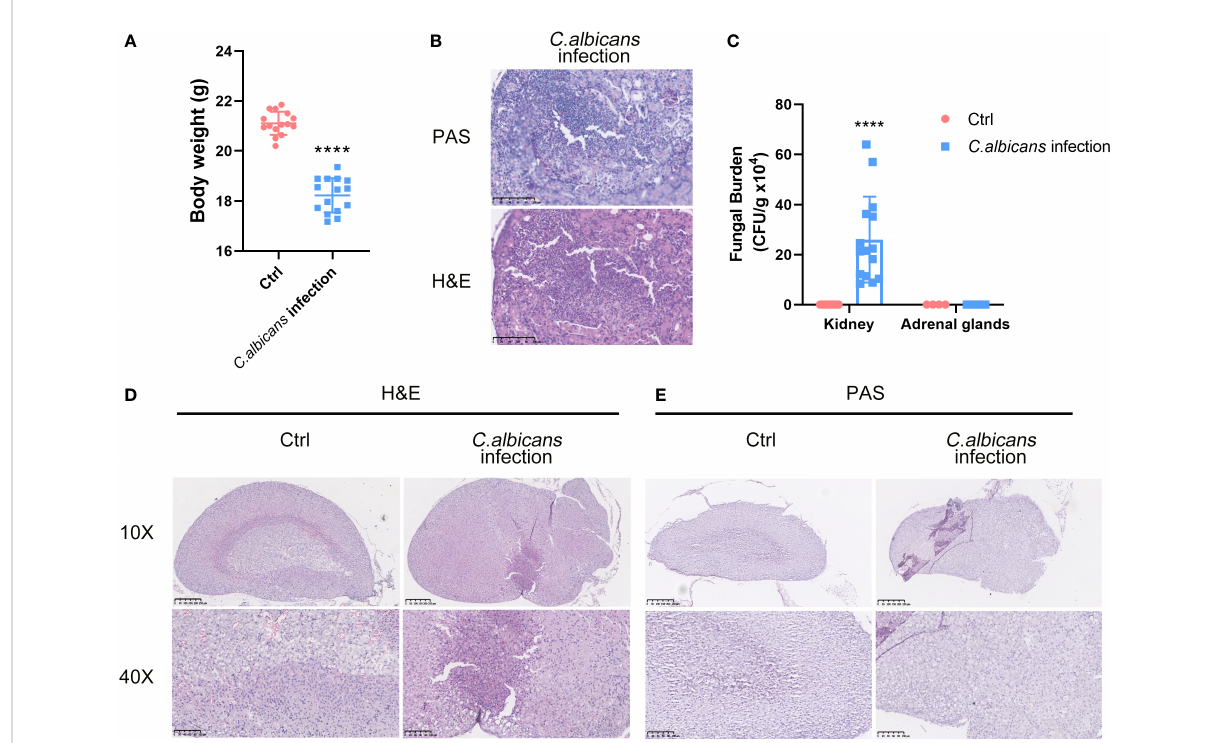
FIGURE 1 Murine model of systemic C. albicans and the histopathological changes in the adrenal glands. Female C57BL/6 mice (n=15) were inoculated with 4 × 10 5 (C) albicans cells/mouse via the lateral tail vein. (A) The body weights of the infected animals and uninfected controls (Ctrl) before sacri fi ce at 48 h post infection. **** P <0.0001. (B) Representative PAS and H&E staining of kidneys from infected mice at 48 h post-infection. The pink fi lamentous stainings by PAS indicated the hyphae in the tissue. Magni fi cation 400×. (C) The average fungal burdens in the kidneys and the adrenal glands of the infected animals and uninfected controls (Ctrl) were counted. **** P <0.0001. (D) H&E staining of the adrenal gland sections from the infected mouse and control. The boundary between the adrenal cortex and medulla became entirely blurred. The examples of hemorrhages, necrotic/apoptotic cells, and in fi ltrated immune cells were indicated by red, yellow, and black arrows, respectively. (E) PAS staining of the adrenal gland showed no obvious hyphae. Magni fi cation 100× and